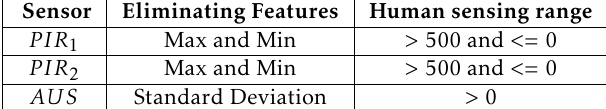
Table 2. Eliminating features and their specified ranges for PIR sensors and AUS for Experiment